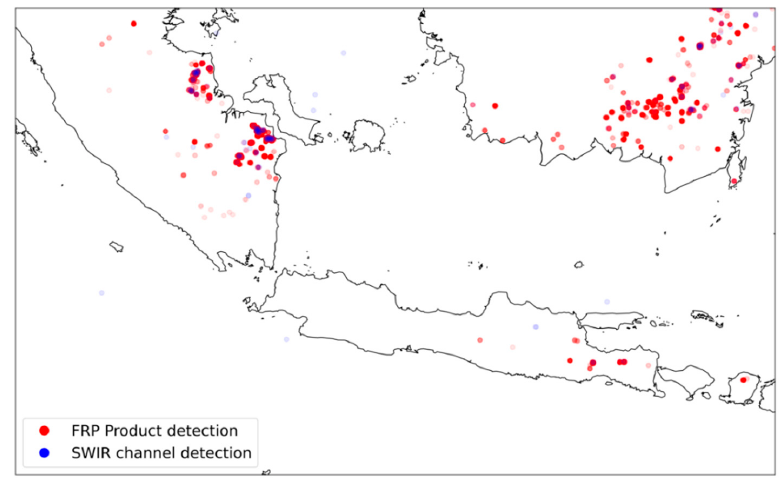
Figure A8. In red are all hotspots detected by the AHI FRP product on 25 September 2015 and in blue are all AHI SWIR pixels with a spectral radiance value >0.1 W m 2 sr − 1 µm − 1 .